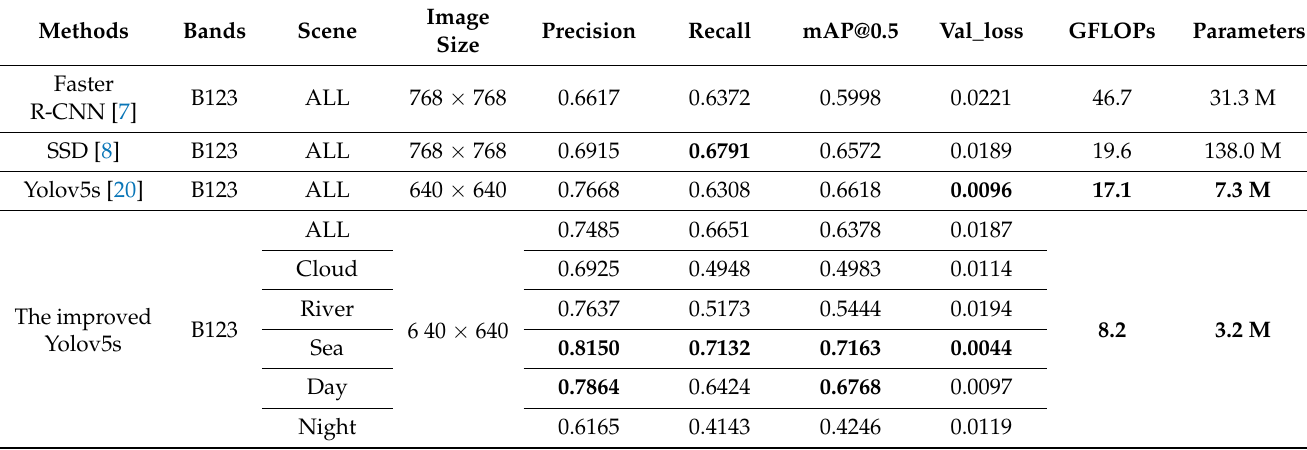
Table 7. The evaluation criteria of different methods by using the TISD (The bold data are the best and second-best results of different